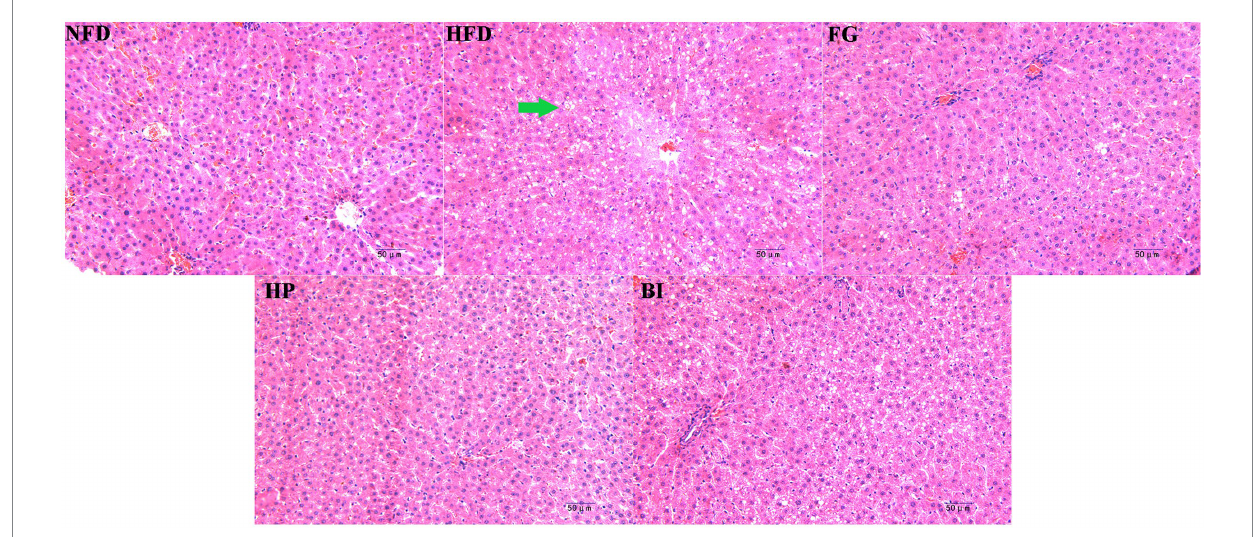
FIGURE 5 Histopathological analysis of liver tissue of rats in different groups at 200× magnification. The lipid droplet vacuoles in the hepatocytes has been marked by green